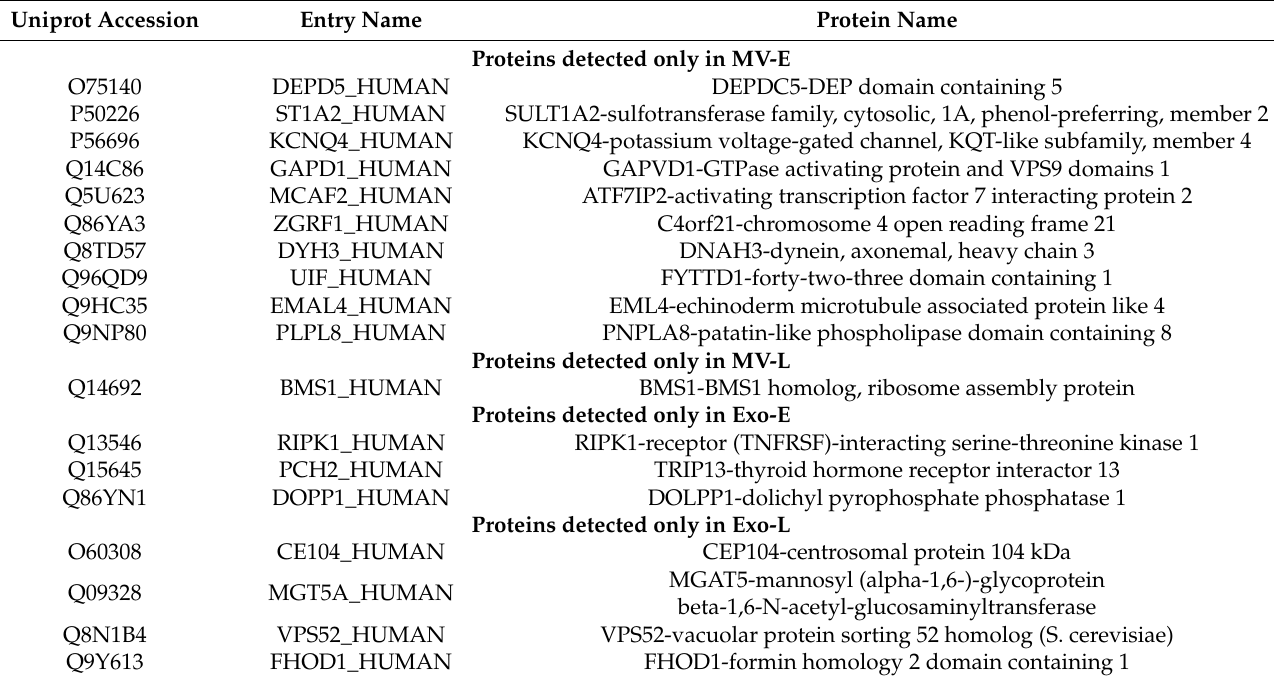
Table 1. List of human proteins detected only in MV-E, MV-L, Exo-E, and Exo-L. Uniprot